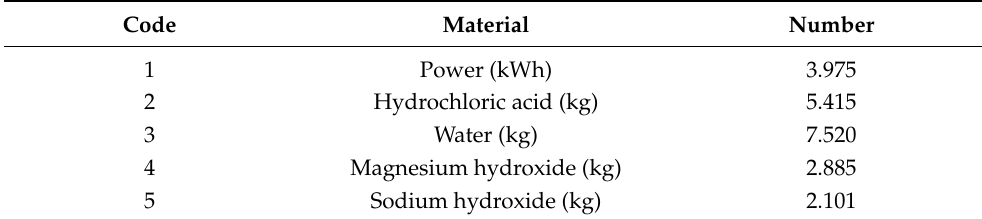
Table 7. Materials required for wet recycling.